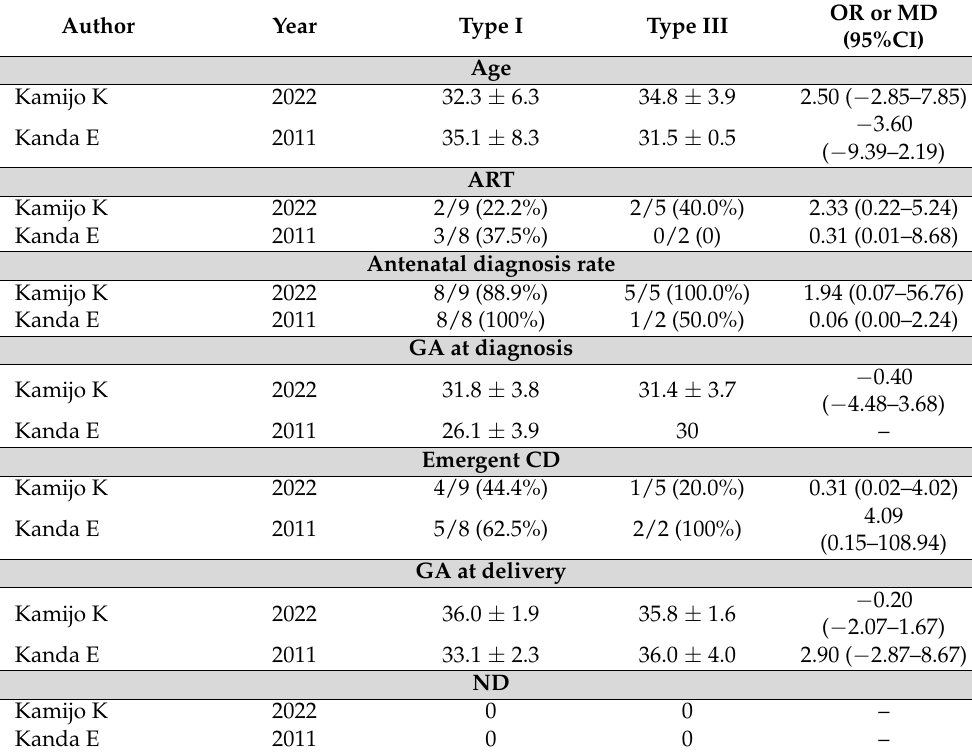
Table 4. The comparison of characteristics and outcomes between type I and type III vasa